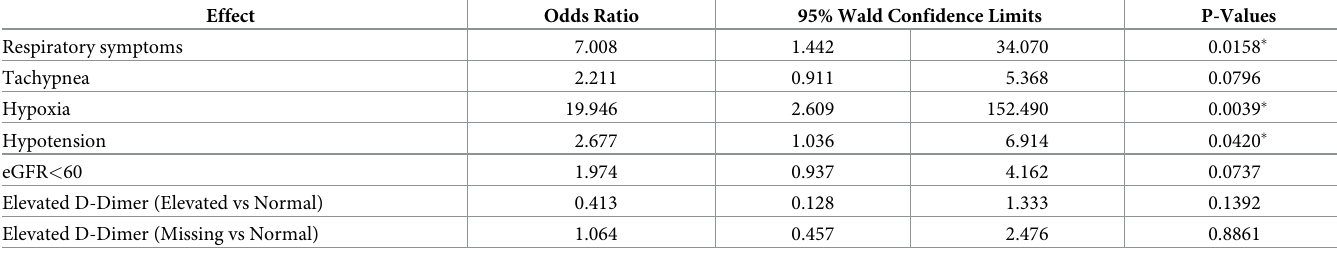
Table 8. Symptoms, signs, and findings associated with progression to severe disease. Multivariate stepwise regression for patients who did not have severe disease or die in the first day of hospitalization (n=223). a